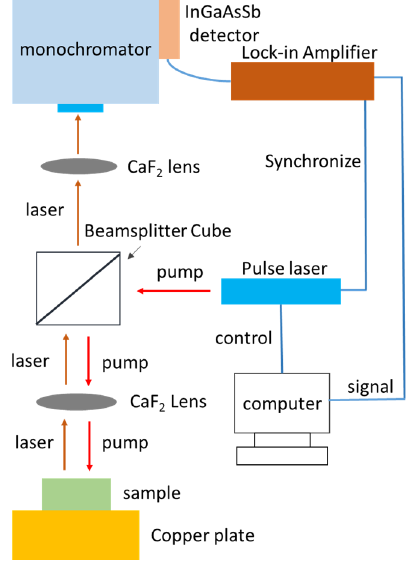
Figure 2. The measurement setup of optical pumping system.